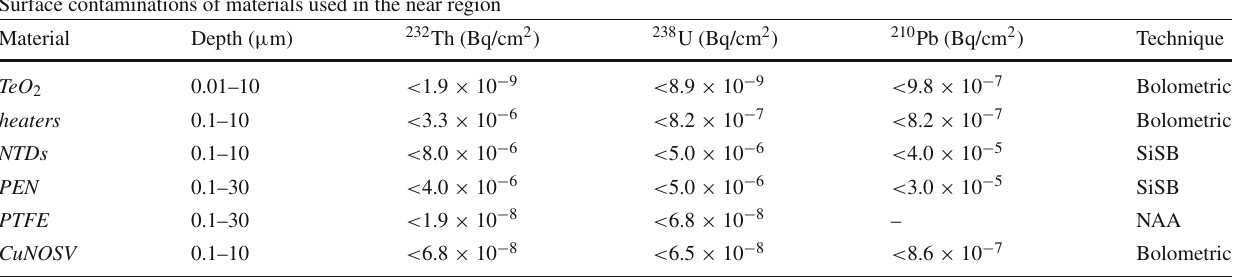
Table 4 90% C.L. upper limits on surface contamination of various CUORE detector components, as obtained in the material screening campaign. To infer the surface contamination from the measured data, different contamination depths were considered (column 1): the limits